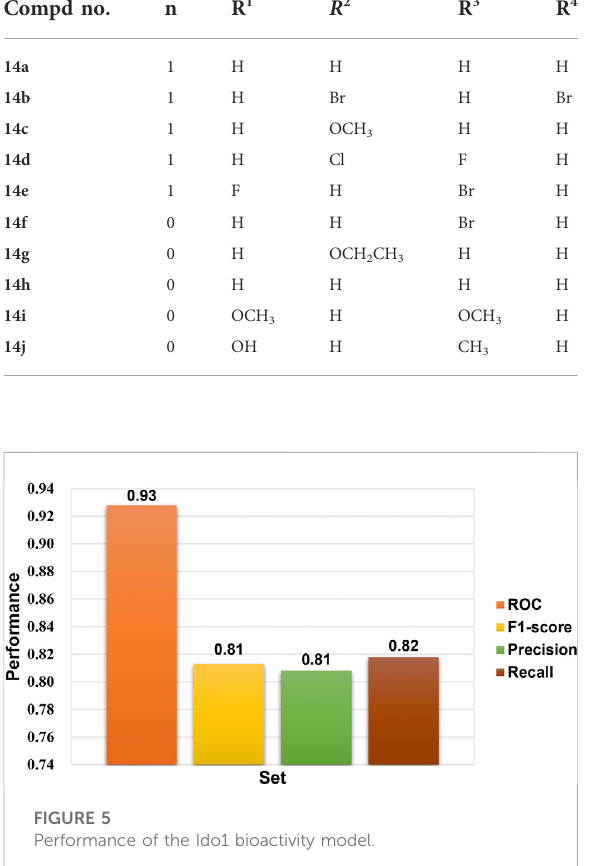
FIGURE 5 Performance of the Ido1 bioactivity model.